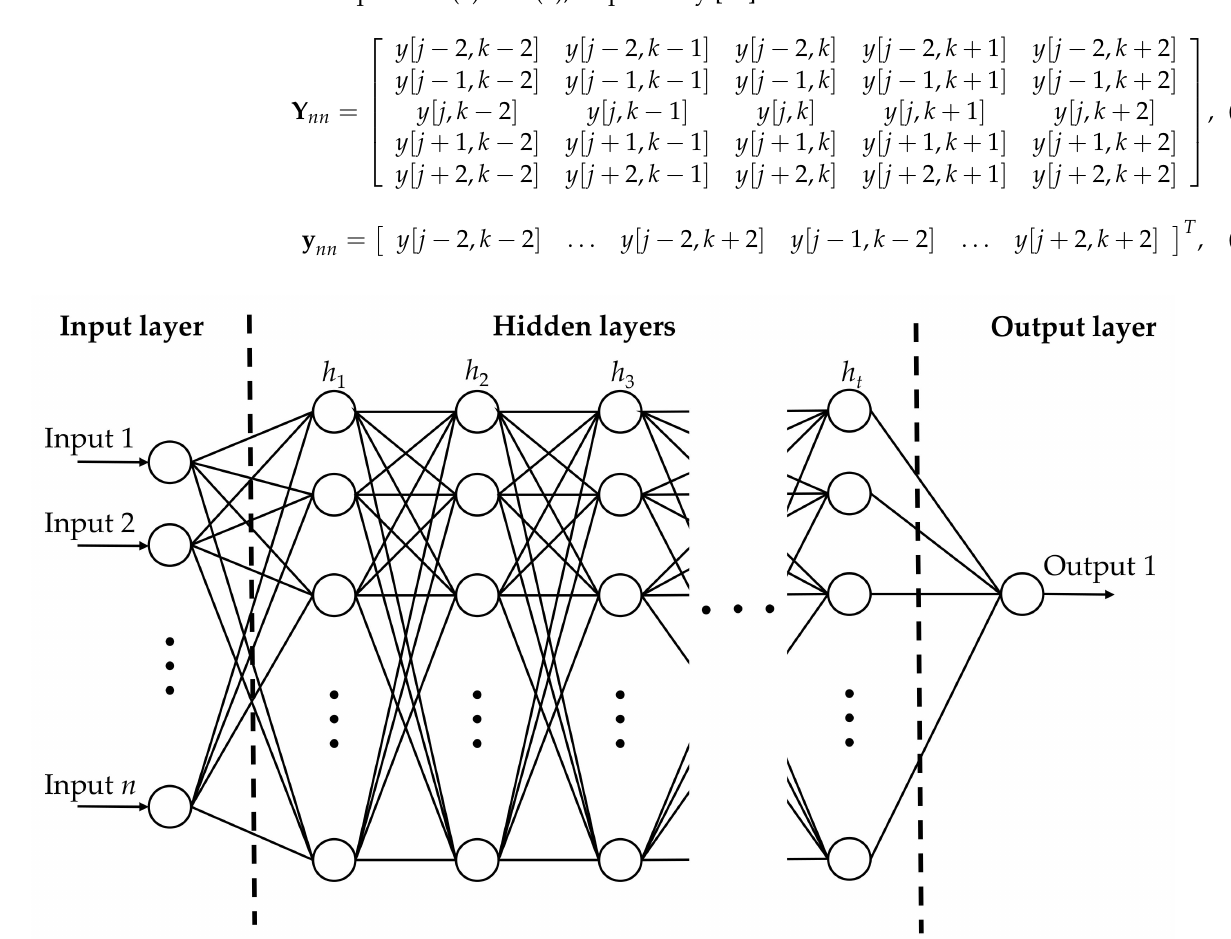
Figure 4. Structure of the neural network.